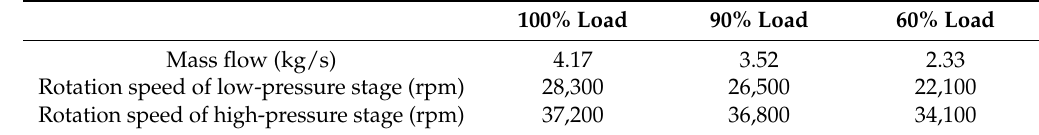
Table 5. Parameters of circular calculation.